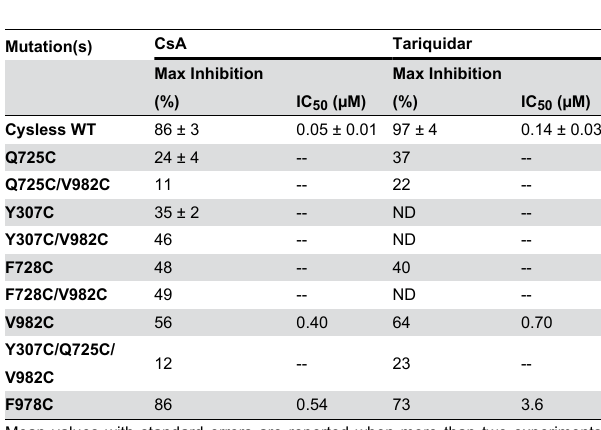
Table 1. Inhibition of IAAP-labeling of mutant Pgps with cyclosporine A and